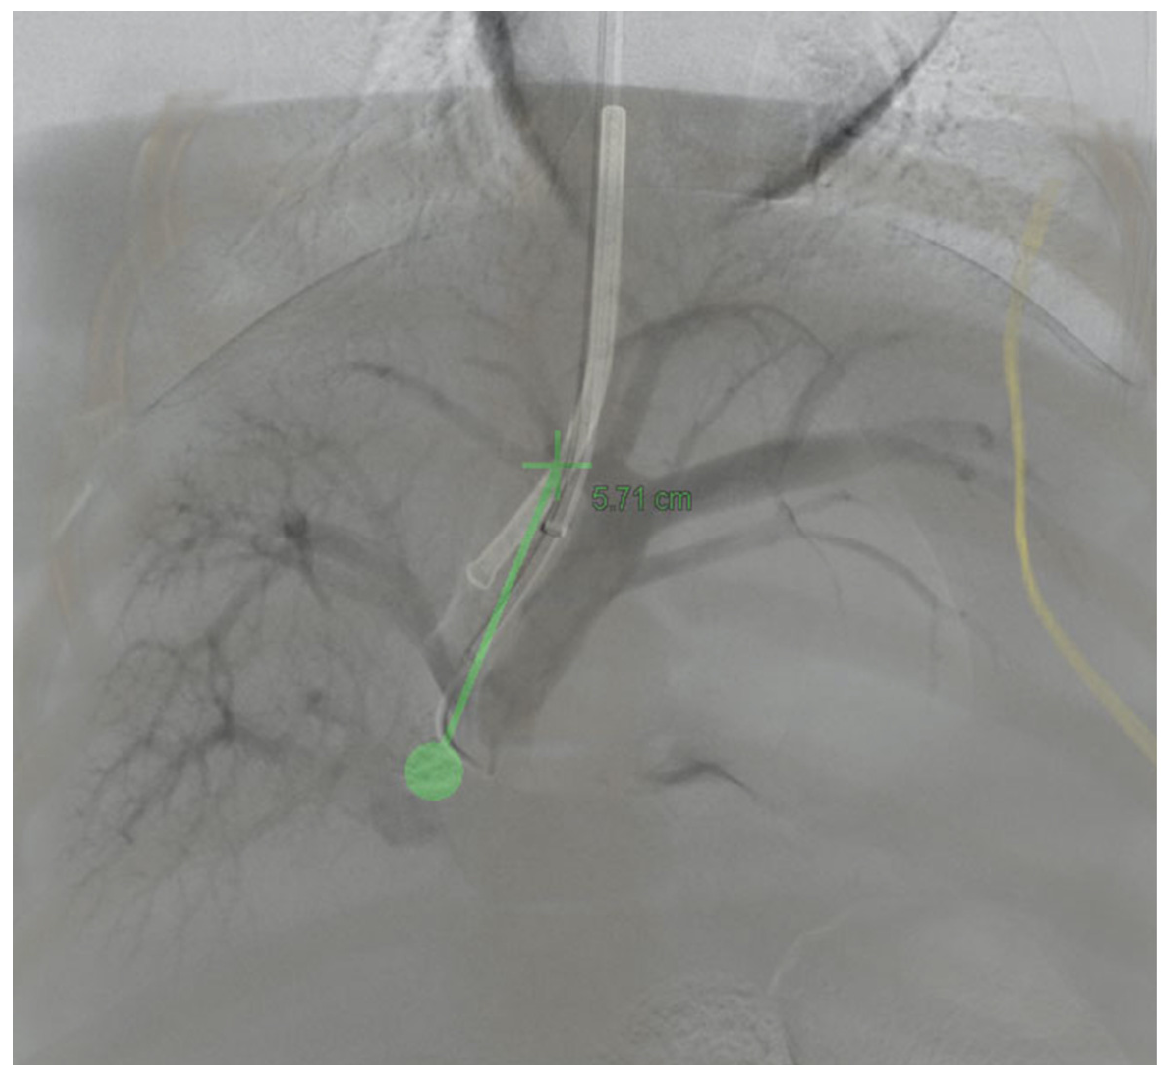
Figure 4. Portal Venogram: a 3DFIG TIPS procedural angiographic image that demonstrates the path of the needle from the hepatic vein to the portal vein (green) and the successful portal venogram after gaining access to the portal vein with TIPS needle.